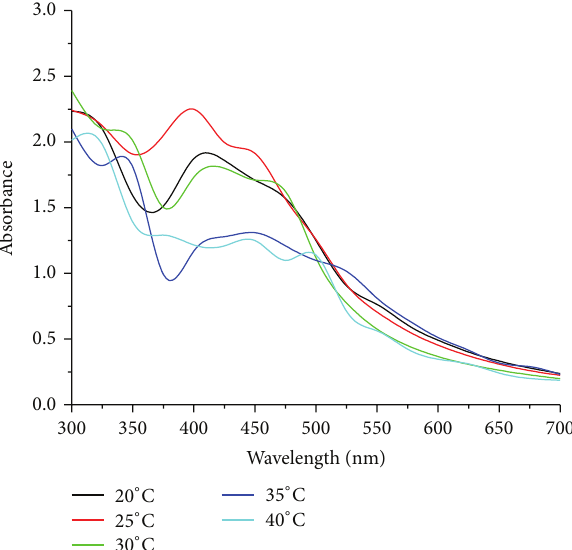
Figure 3: UV-visible absorption spectra of AgNps at different concentrations of AgNO 3 .